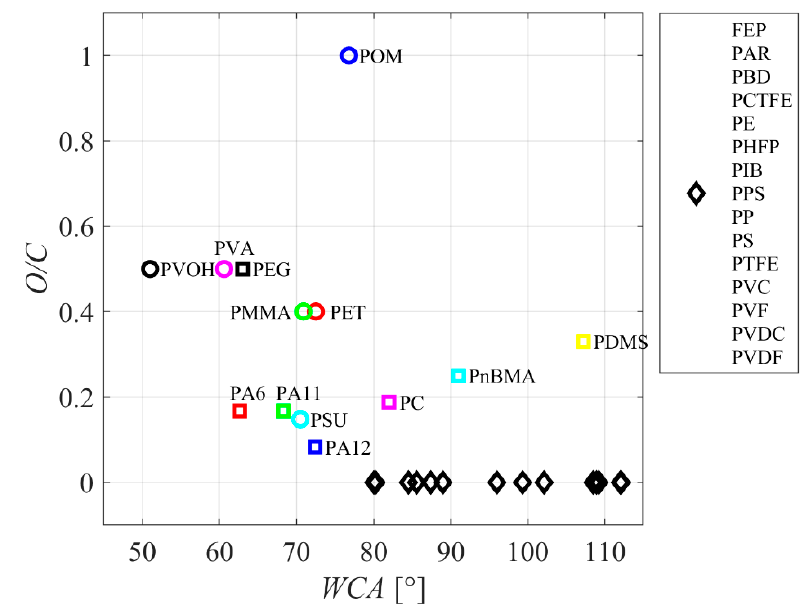
Figure 1. The oxygen content in polymers versus water contact angle. FEP—fluorinated ethylene